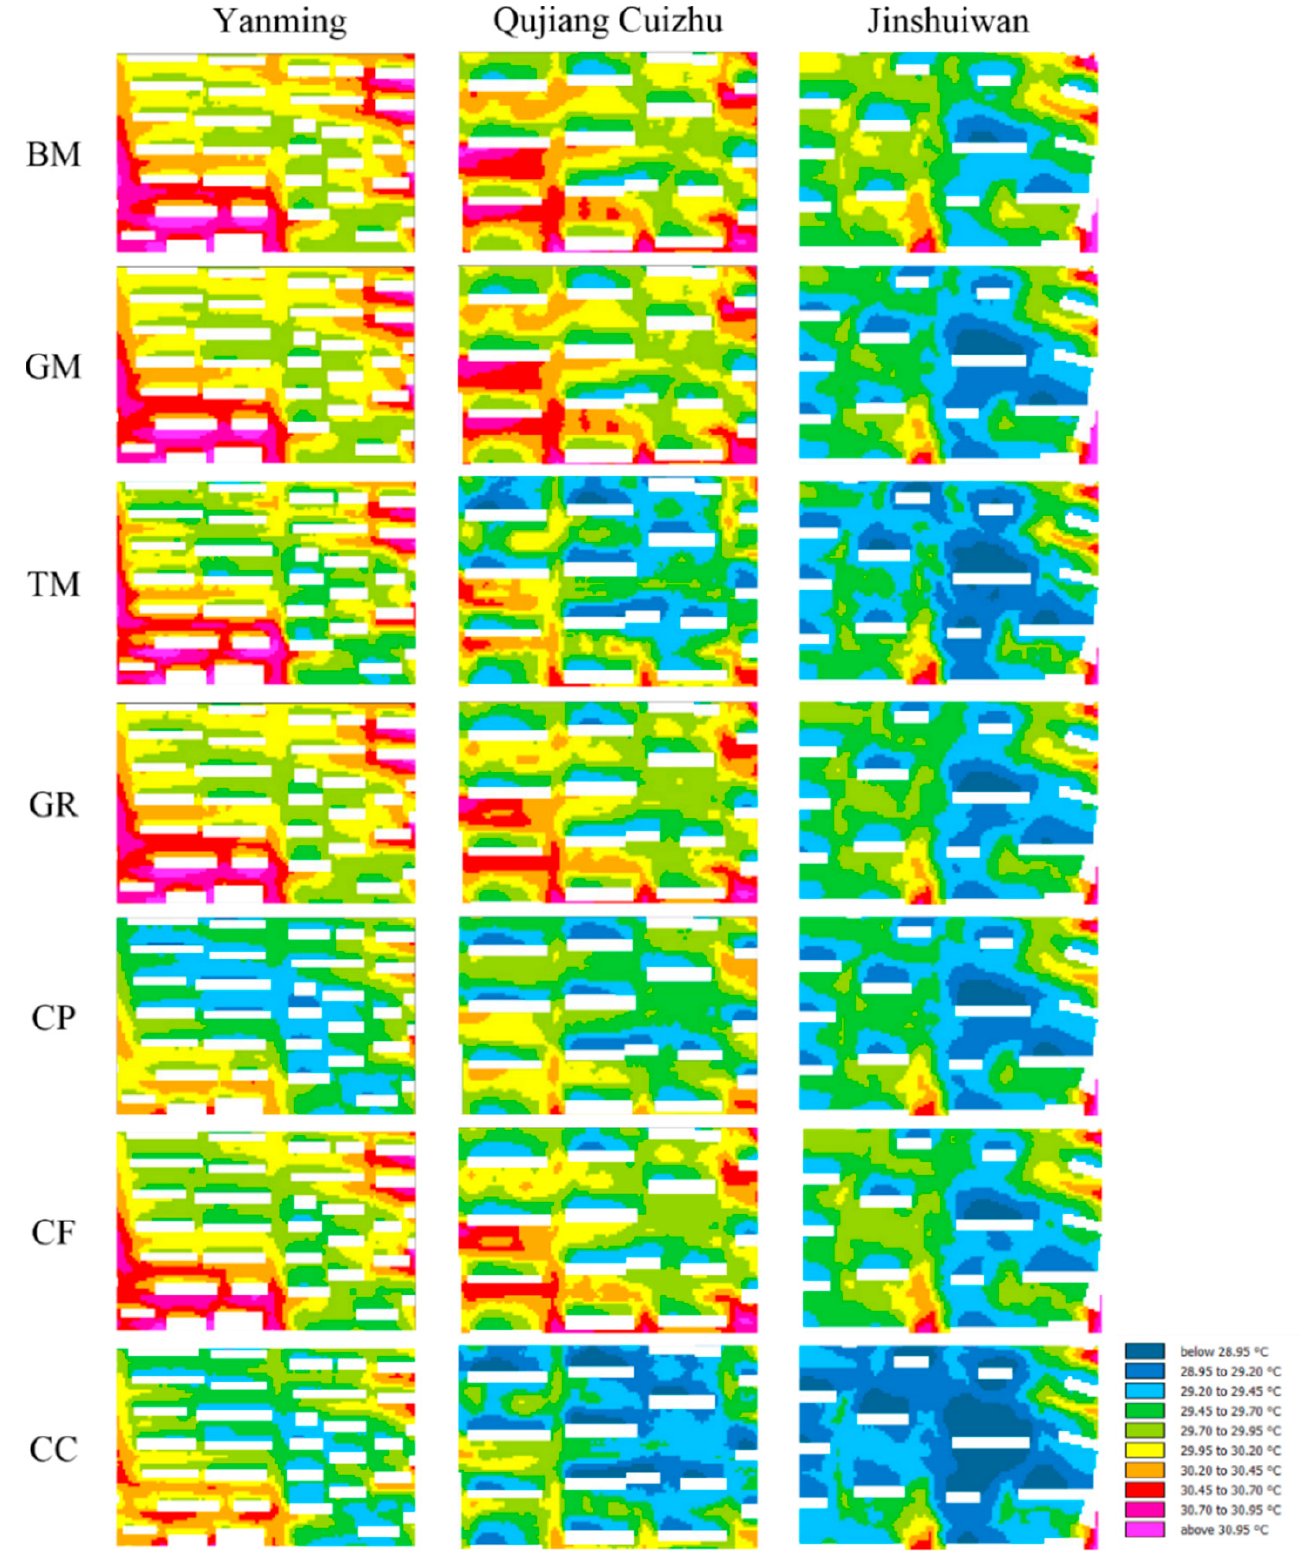
Figure 8. Simulation results of AT distribution in the central part of the three districts at 13:00.